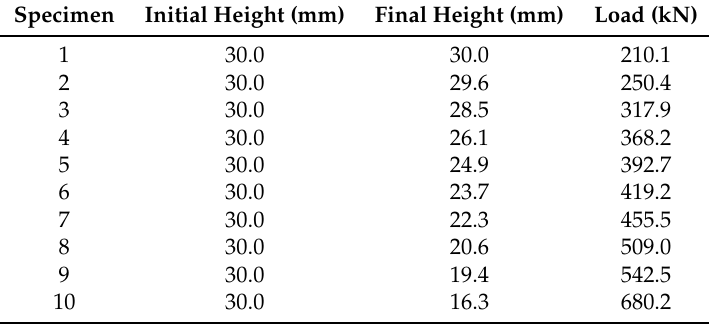
Table 1. Compression tests in SAE 1010 carbon